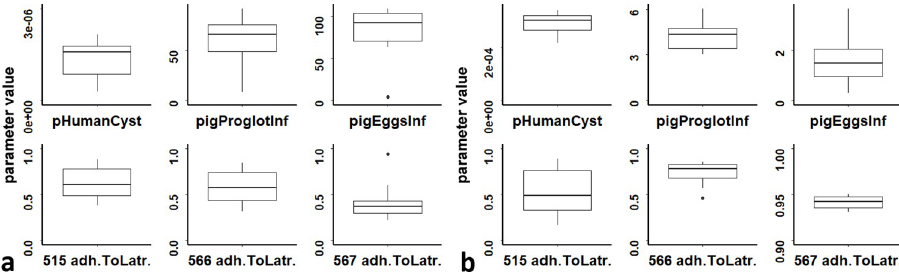
Fig 4. ABC posteriors distribution. Posterior distributions of model calibration parameters for the two calibration setups: panel a: necro calibration setup (fourth ABC-SMC stage). Panel b: noNecro calibration setup (third ABC-SMC stage). Horizontal bold lines indicate the posterior distribution median, boxes cover the parameter values above the first quartile and below the third quartile and vertical lines show maximum and minimum values. Black dots show